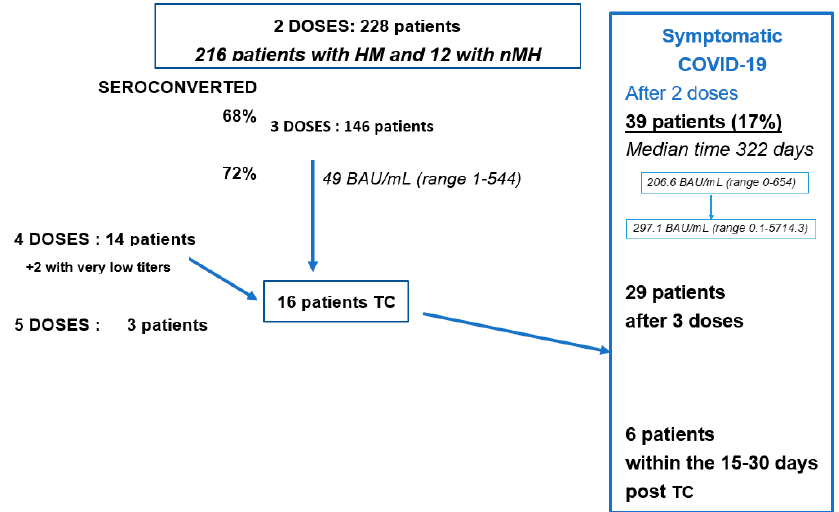
Figure 2. Summary of follow-up including patients who had symptomatic COVID-19. Abbreviations: HM: hematological malignancies; nMH: non-malignant hemopathies; TC: tixagevimab/cilgavimab (EVUSHELD ® ).